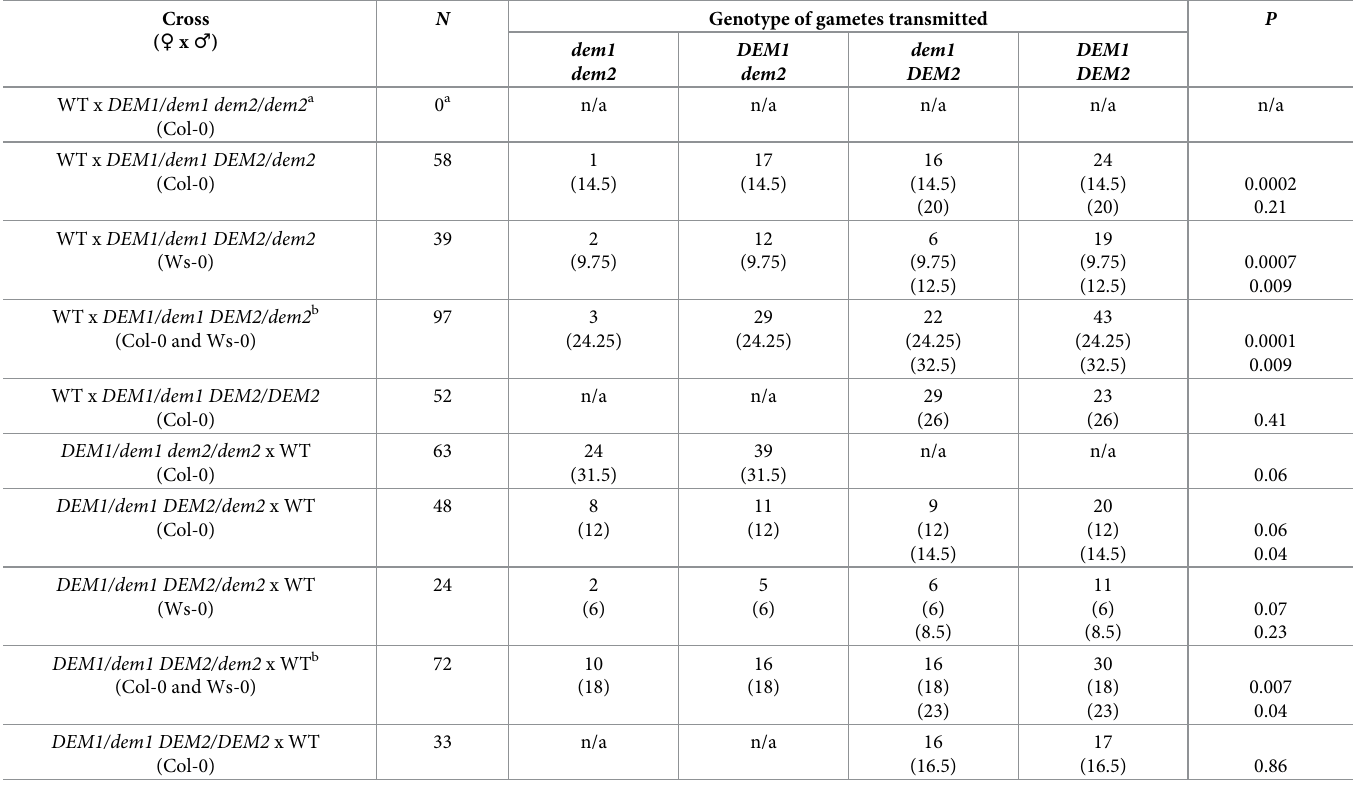
germline was highly significant ( P < 0.01; Table 1). However, despite the reduced co-transmis- sion of dem1 and dem2 alleles, a significant portion of dem1 dem2 genotypes were still trans- mitted to the next generation (Table 1). Furthermore, at a stage when ovules of wild-type plants were fertilized and contained developing embryos, self-fertilized DEM1/dem1 dem2/ dem2 Ws-0 plants had approximately 50% of embryo sacs arrested before the first or second round of post-meiotic mitosis (Fig 6). Thus, high ovule abortion rate observed in DEM1/dem1 dem2/dem2 plants (Fig 4) is most likely due to defects in both pollen (Fig 5A–5C) and embryo sac viability (Fig 6). As was the case for pollen, there was a significant segregation distortion against dem1 DEM2 female gametes compared to DEM1 DEM2 female gametes for DEM1/dem1 DEM2/ dem2 plants ( P < 0.05) but not for DEM1/dem1 DEM2/DEM2 plants ( P = 0.86; Table 1). Table 1. Transmission of gametes depends on the dosage of functional DEM alleles in both the gametes and the plant that undergoes meiosis to produce the gam- etes. Segregation data from crosses involving dem mutations in the two genetic backgrounds (Col-0 and Ws-0) were analyzed separately and together for significance. The expected segregation of genotypes assuming equal transmission of wild-type DEM and mutant dem alleles is listed in brackets. N , number of progeny scored; P , probability for a chi-square distribution with three degrees of freedom and an expected segregation ratio of 1:1:1:1, or with one degree of freedom and an expected segregation ratio of 1:1. For some crosses, chi-square probabilities were also determined for observed and expected segregation ratios for just dem1 DEM2 versus DEM1 DEM2 gametes, and these probabilities are listed in the third row of the table for these crosses. Cross N Genotype of gametes transmitted P ( ♀ x ♂ ) dem1